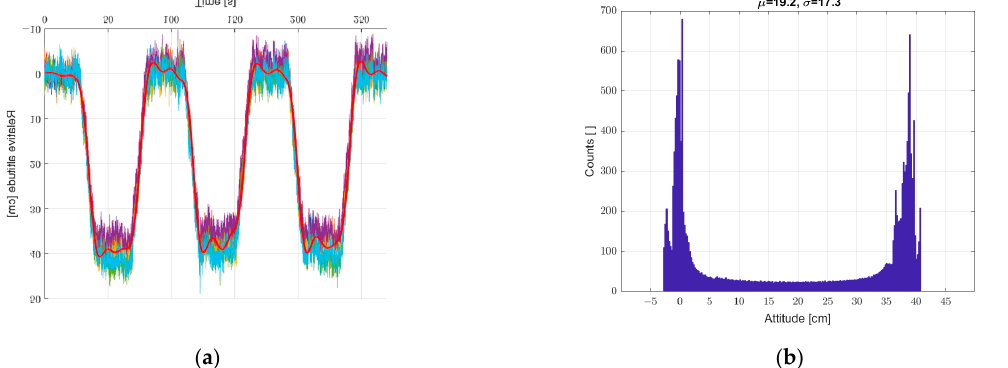
Figure 12. ( a ) Graph over time with 6 + 1, bold graph calculated from data averaged and filtered with IIR low-pass filter, and ( b ) histogram. Dynamic measurements—sensor array in motion. The tests conducted until now were carried out in a closed room without forced air